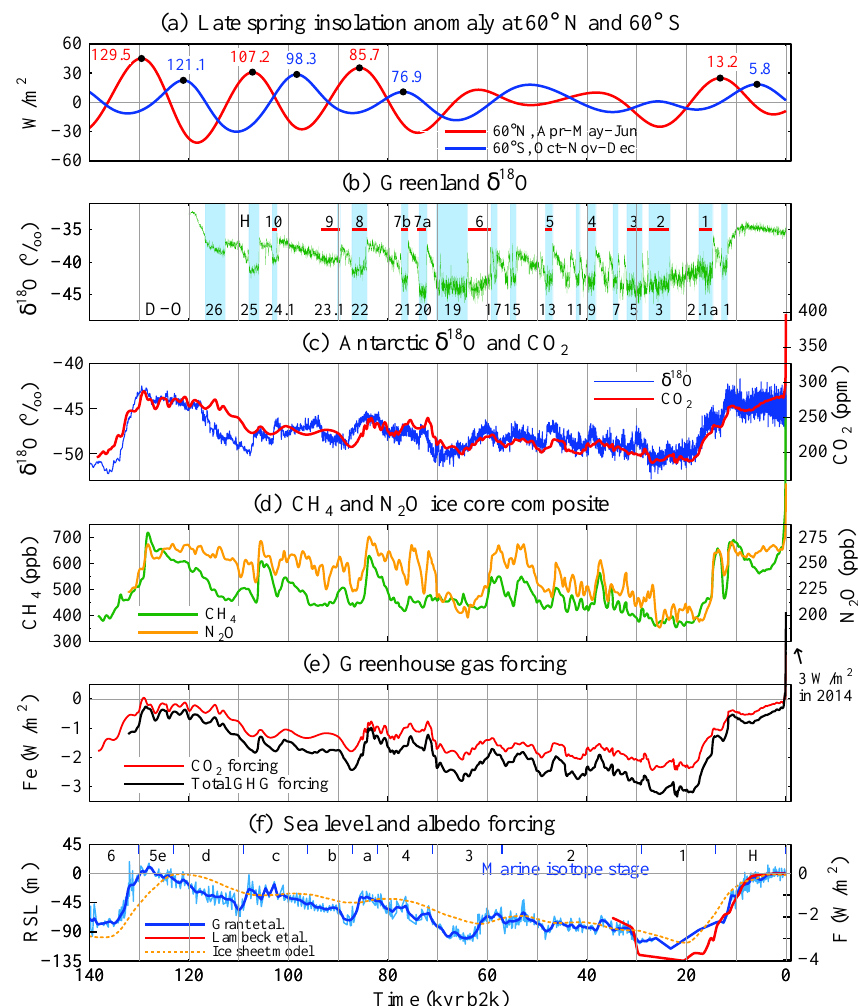
Figure 27. (a) Late spring insolation anomalies relative to the mean for the past million years. (b) δ 18 O ice of composite Greenland ice cores (Rasmussen et al., 2014) with Heinrich events of Guillevic et al. (2014). (c, d) δ 18 O ice of EDML Antarctic ice core (Ruth et al., 2007), multi-ice-core CO 2 , CH 4 , and N 2 O based on a spline fit with a 1000-year cut-off (Schilt et al., 2010); scales are such that CO 2 and δ 18 O means coincide and standard deviations have the same magnitude. (e) GHG forcings from equations in Table 1 of Hansen et al. (2000), but with the CO 2 , CH 4 , and N 2 O forcings multiplied by factors 1.024, 1.60, and 1.074, respectively, to account for each forcing’s “efficacy” (Hansen et al., 2005a), with CH 4 including a factor of 1.4 to account for indirect effect on ozone and stratospheric water vapor. (f) Sea level data from Grant et al. (2012) and Lambeck et al. (2014) and ice sheet model results from de Boer et al. (2010). Marine isotope stage boundaries from Lisiecki and Raymo (2005). Panels (b–e) are on AICC2012 timescale (Bazin et al.,